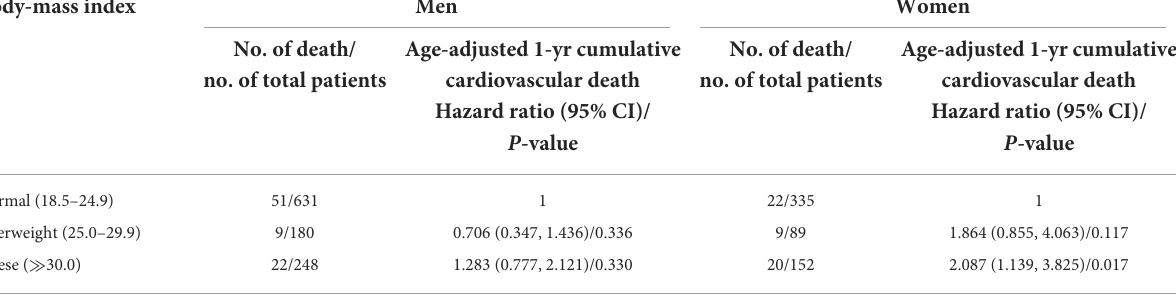
TABLE 2 Cumulative incidence of cardiovascular death among study participants according to the category of body-mass index at base line. Body-mass